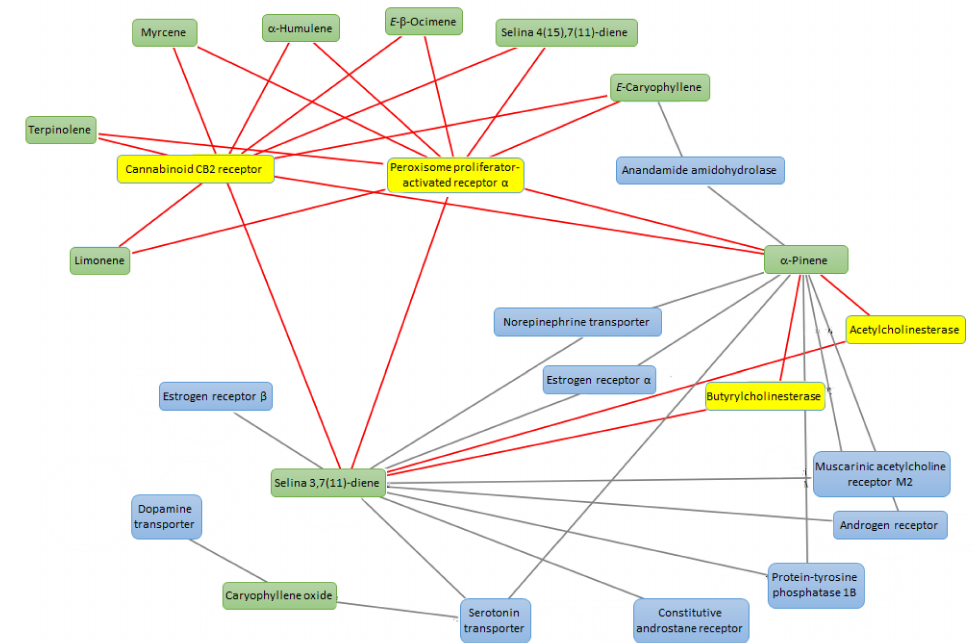
Figure 2. Network pharmacology analysis underlying the theoretical interactions between essential oil phytochemicals, namely α -pinene, α -humulene, E -caryophyllene, E - β -ocimene, myrcene, terpinolene, limonene, selina-4(15),7(11)-diene, selina-3,7(11)-diene, caryophyllene oxide and multiple mouse target proteins, including acetylcholinesterase, cannabinoid CB2 receptor, peroxisome proliferator-activated receptor α . The molecular targets were identified through the bioinformatics platform SwissTargetPrediction, as well as the components-targets plot was built through Cytoscape software (3.8 version).